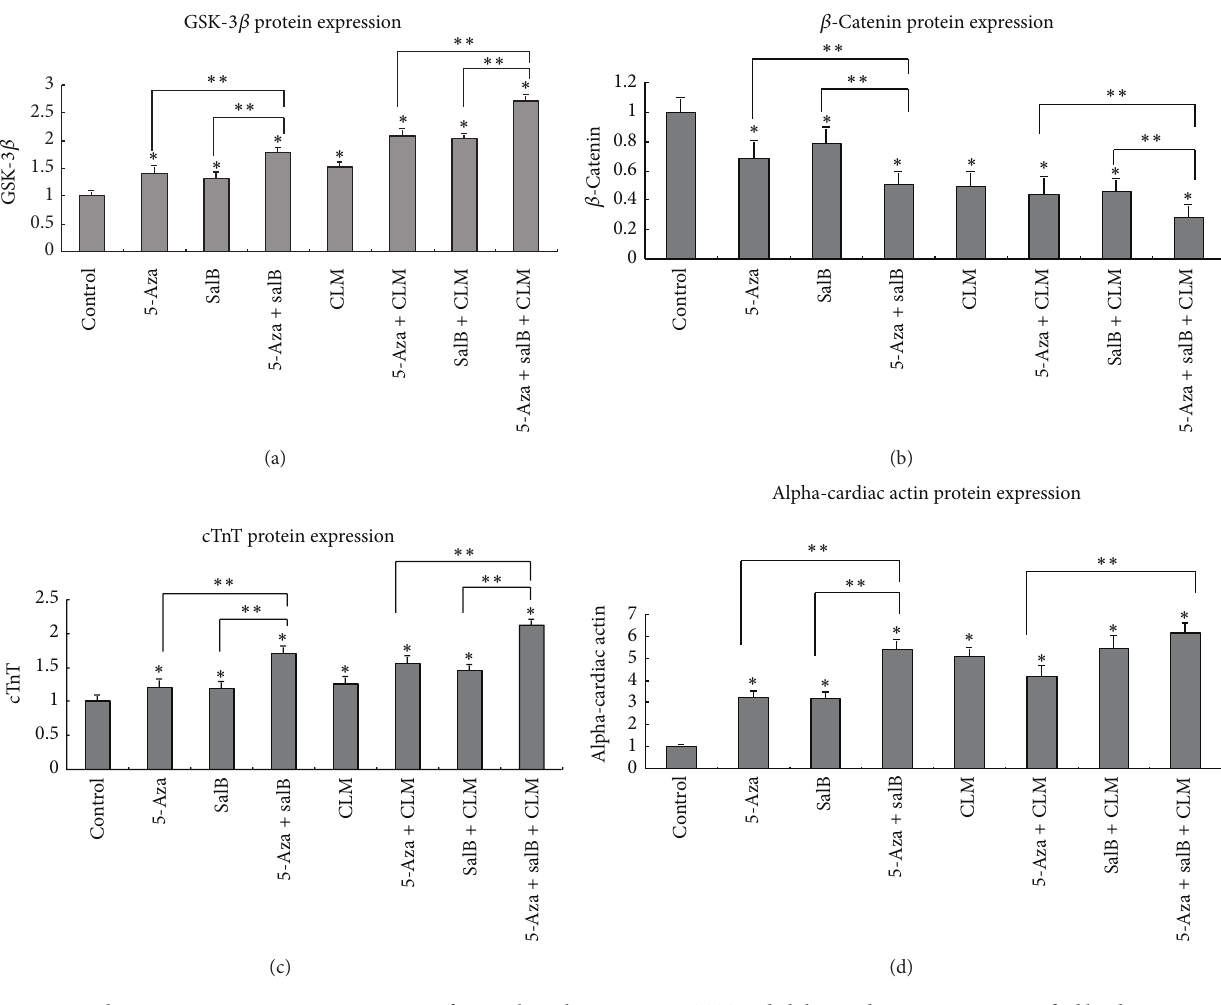
Figure 6: Relative protein expression. Expression of GSK-3beta, beta-catenin, cTnT, and alpha-cardiac actin was quantified by densitometric analysis of the immunoblots. ∗ 𝑃 < 0.05 compared to the control group. ∗∗ 𝑃 < 0.05 compared between the two groups as shown in the figure.